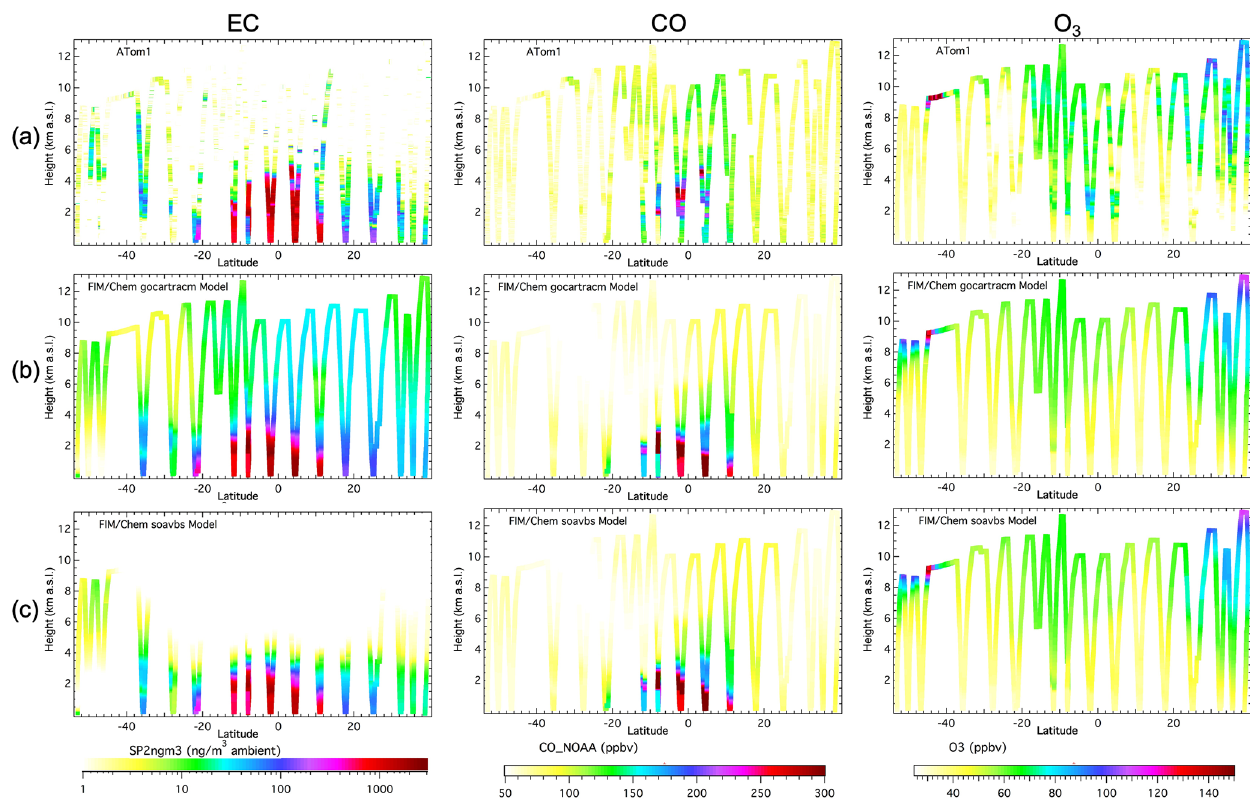
Figure 6. Height–latitude profiles of EC (elemental carbon), CO, and O 3 over the Atlantic on 15 August and 17 August 2016 for (a) ATom-1; (b) RACM_GOCART; and (c)